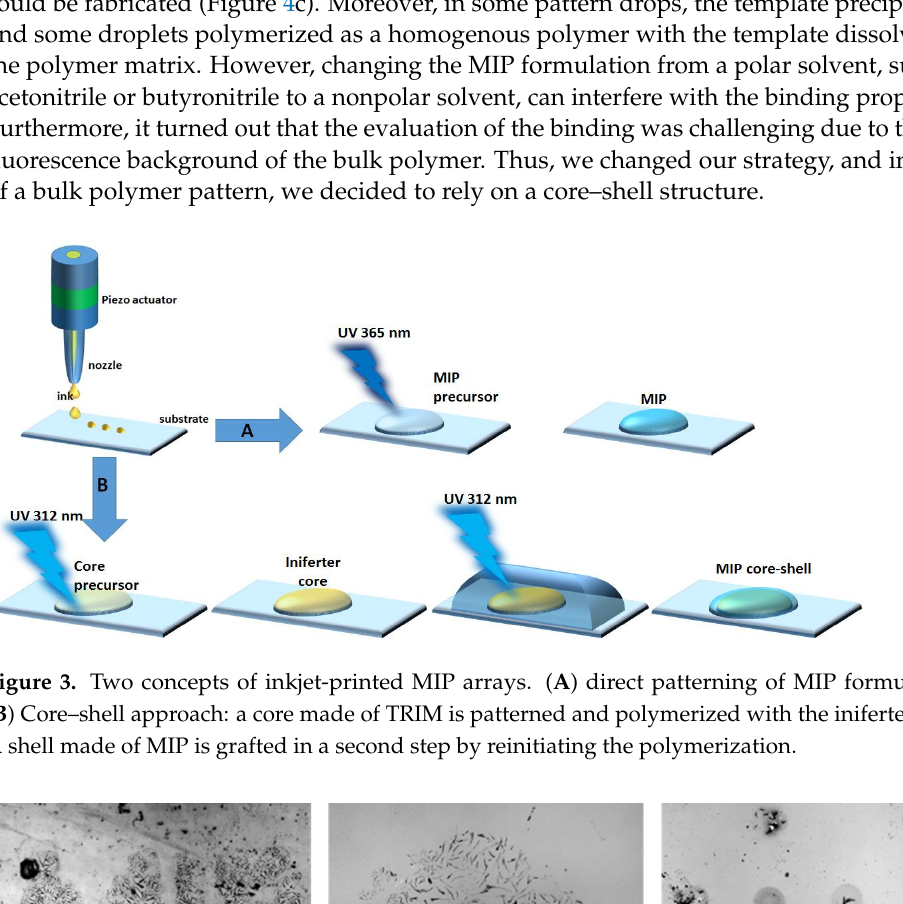
Figure 3. Two concepts of inkjet-printed MIP arrays. ( A ) direct patterning of MIP formulation; ( B )